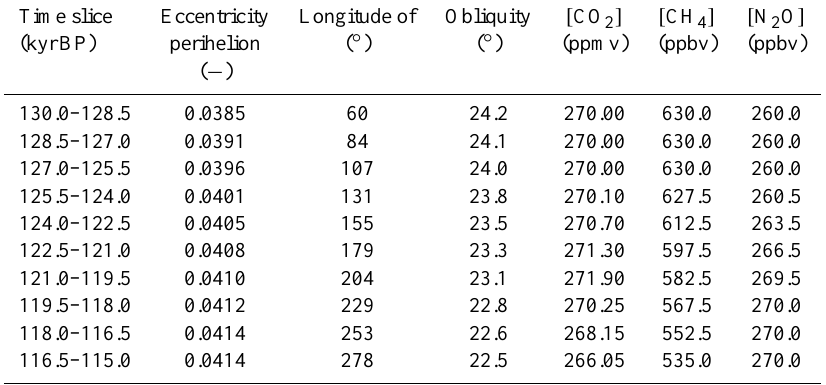
Table 1. Climate model forcing parameters. Orbital parameters are calculated for the midpoint of each time slice (Berger and Loutre, 1991). Greenhouse gas concentrations between 130 and 125kyrBP follow the ECHO-G settings (Kaspar et al., 2007). The concentrations between 125 and 115kyrBP follow the observed concentrations in the Vostok ice core (Petit et al., 1999; Sowers, 2001).